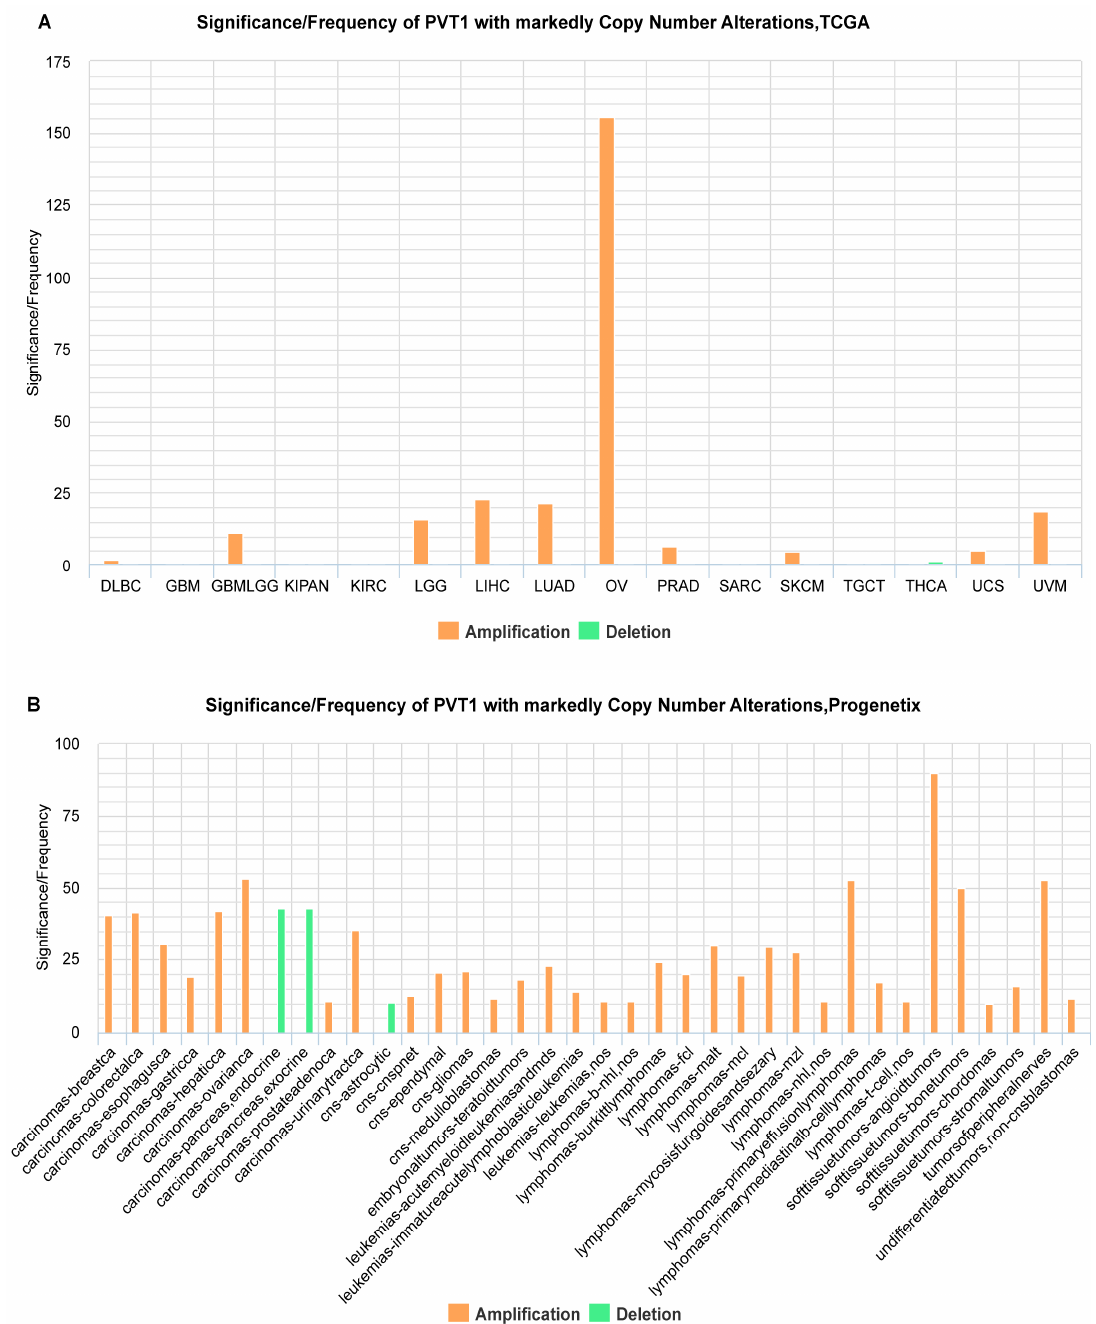
Figure 4. An example showing how users discover the frequently amplified lncRNAs using oncoNcRNA web portal. ( A ) PVT1 shows recurrent SCNAs in 16 TCGA cancer types. The y axis shows the –log10 (q value; ( B ) PVT1 shows recurrent SCNAs in 36 Progenetix cancer types. The y axis shows the frequency.